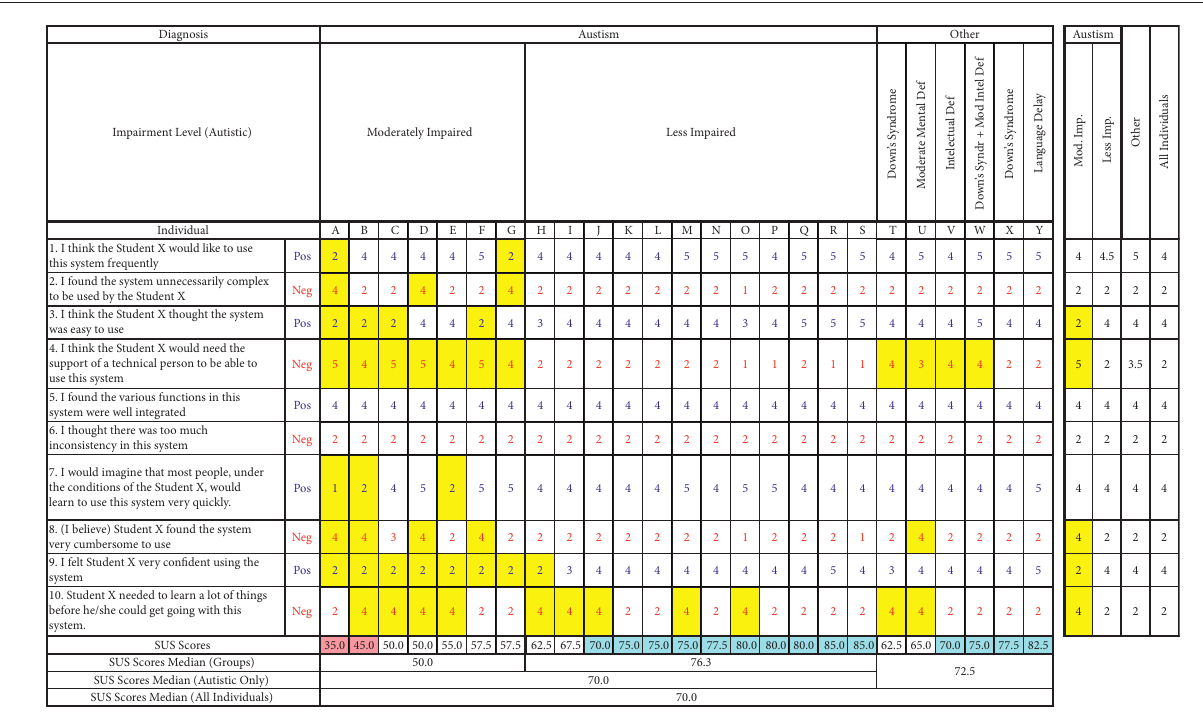
Figure 12: Acceptability ranges for SUS scores [35]. Table 1: Answers to the SUS